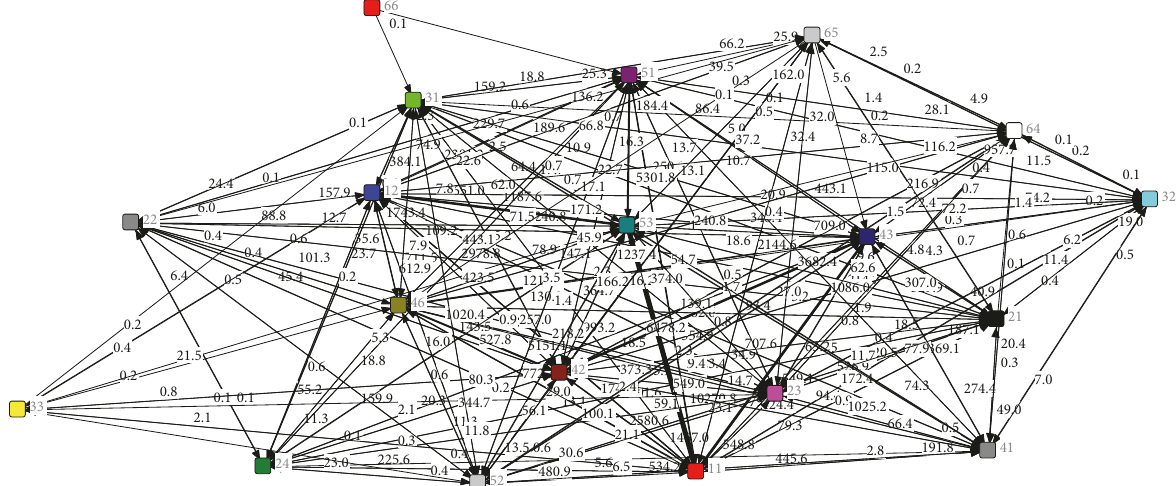
Figure 11: The topology of land system networks showing the conversions among land cover types in